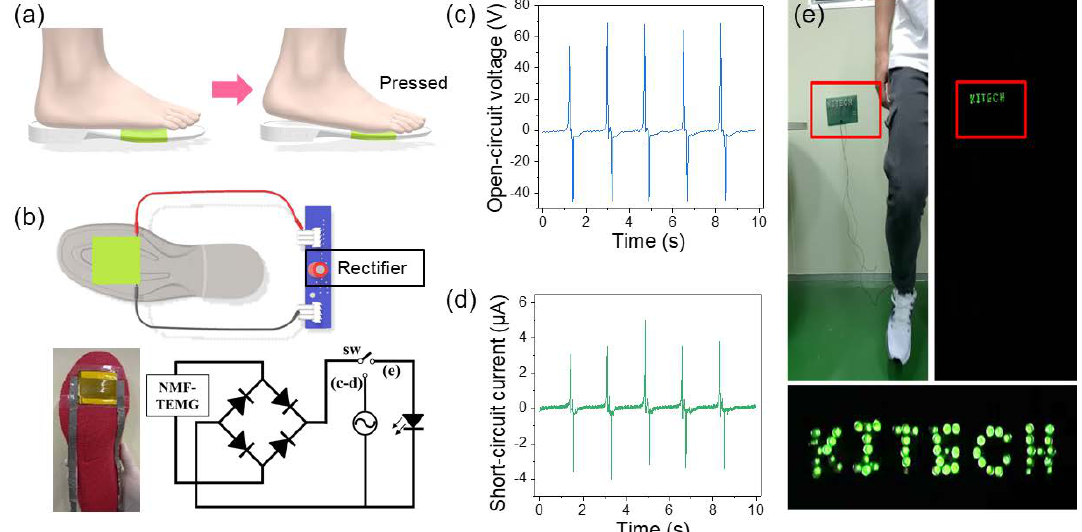
Figure 5. Demonstration of energy generation by human walking. ( a ) Schematics of the working principle and ( b ) circuit configuration for an energy-harvesting insole. ( c ) V oc and ( d ) I sc generated by human walking. ( e ) Photograph of 57 LEDs with stable luminance powered by human